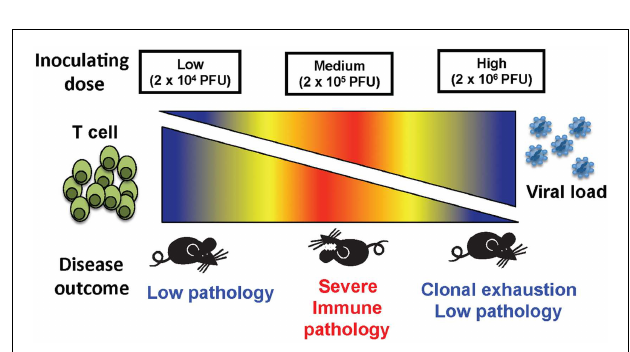
FIGURE 5 |The balance between viral load andT cell response determined the disease outcome of mice inoculated at three different doses of virus . A low dose of LCMV results in a strongT cell response that quickly clears virus and causes little immunopathology. At a high dose of LCMV, theT cell response is clonally exhausted leading to limited immunopathology even though there is persistent virus. An intermediate dose of LCMV induces only a partial clonal exhaustion and mice develop severe immunopathology with up to 75%